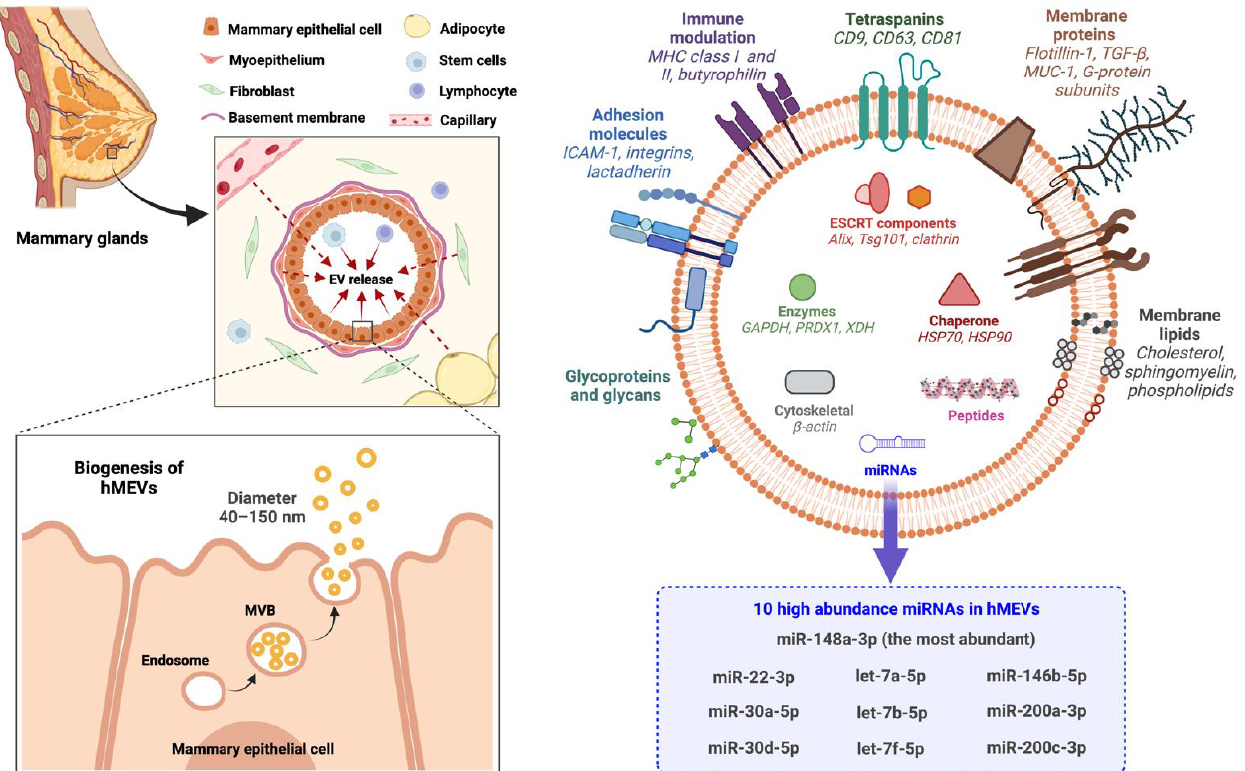
Figure 2. HMEV biogenesis and compositions. EV, extracellular vesicles; GAPDH, glyceraldehyde- 3-phosphate dehydrogenase; hMEVs, human milk extracellular vesicles; HSP, heat shock protein; ICAM-1, intercellular adhesion molecule 1; MHC, major histocompatibility complex; miRNAs, mi- croRNAs; MUC-1, mucin-1; MVB, multivesicular bodies; PRDX1, peroxiredoxin 1; TGF-  , tumor necrosis factor-  ; Tsg101, tumor susceptibility gene 101; XDH, xanthine